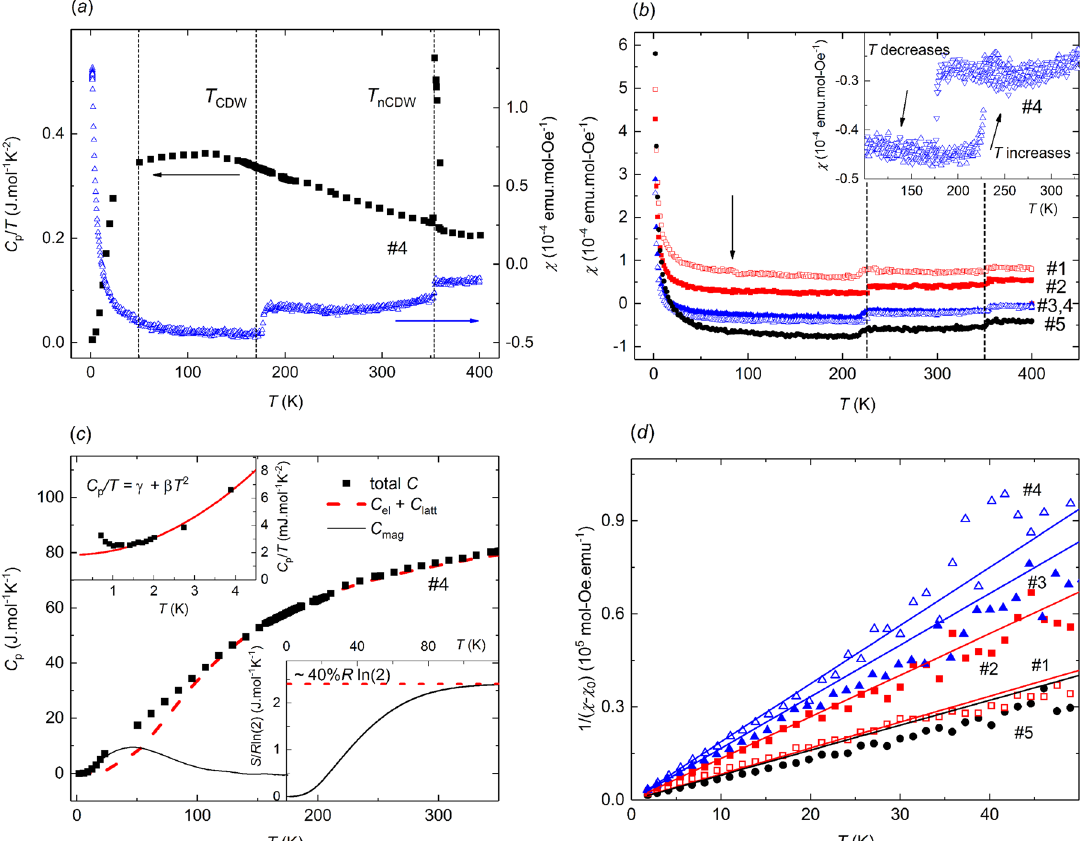
Fig. 1 Magnetic and thermodynamic properties of 1T-TaS 2 a Comparison of the temperature dependence of speci fi c heat and magnetic susceptibility of the 1T-TaS 2 single crystal #4 measured upon cooling. The dashed lines mark the position of the transitions at T CDW ~160 K and T nCDW ~355 K and the temperature ~50 K, below which an upturn in both data sets is observed. b The temperature dependence of the magnetic susceptibility measured on fi ve 1T-TaS 2 single crystals in magnetic fi eld of 0.2 T upon warming. The dashed lines mark the transition at T CDW ~ 210 K and T nCDW ~ 355 K. The inset shows the blown-up picture of the data near T CDW for the single crystal #4 measured upon cooling and warming. c Total speci fi c heat of the 1T-TaS 2 single crystal #4 ( closed squares ) with the estimated lattice and electronic ( dashed line ) contribution and the magnetic ( solid line ) contribution. The low-temperature region of the speci fi c heat is shown in the upper inset. The red line is the Sommerfeld fi t to the data as given by the equation C p /T = γ + ßT 2 . The magnetic entropy is shown in the lower inset. Approximately 40% of the theoretical maximum entropy (5.76 J mol − 1 K − 1 ) is released as marked by the red dashed line . d The temperature dependence of the inverse magnetic susceptibility of the fi ve 1T-TaS 2 single crystals from b and their respective Curie – Weiss fi